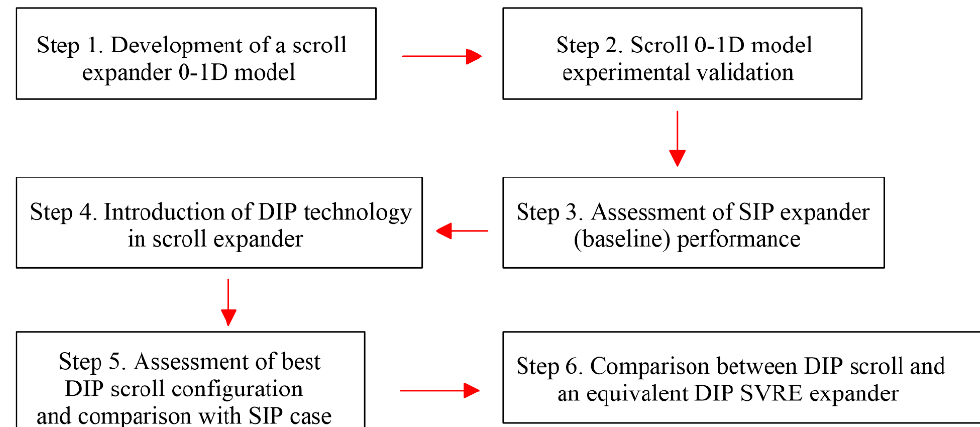
Figure 1. Approach followed for the feasibility assessment of DIP scroll expander technology.